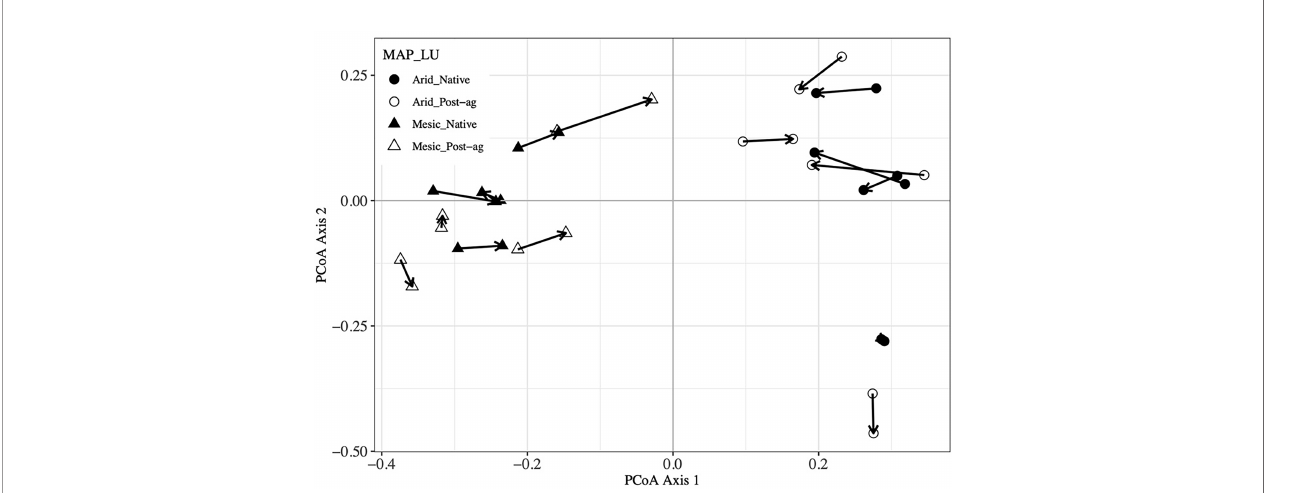
FIGURE 5 | Procrustes analysis of plant community Principal Coordinates Analysis (PCoA) fi rst and second ordination axes compared with Fungal Operational Taxonomic Unit (OTU) PCoA axes. Arrows point from plant community sample to the corresponding fungal community sample within a